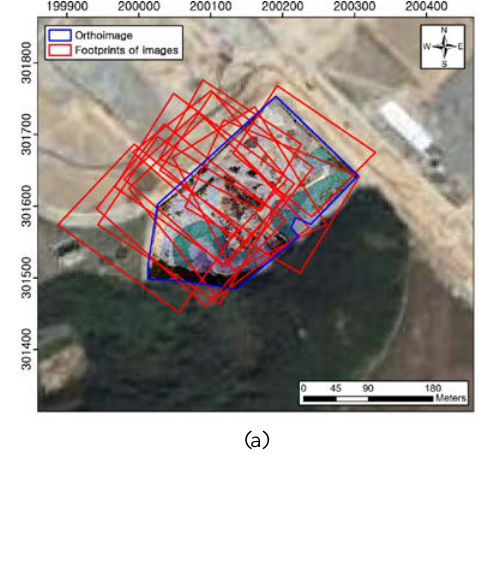
Figure 4. Vibration-proof device designed to reduce high- frequency vibrations in an electric glider. The smartphone is attached to the balsa framework with